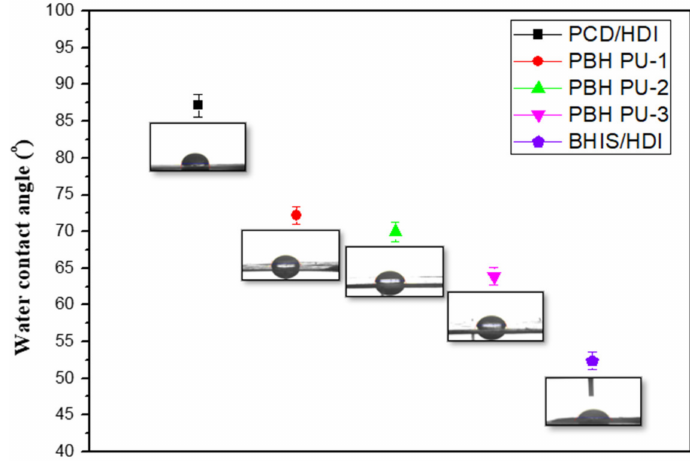
Figure 8. Contact angle images of polyurethanes.